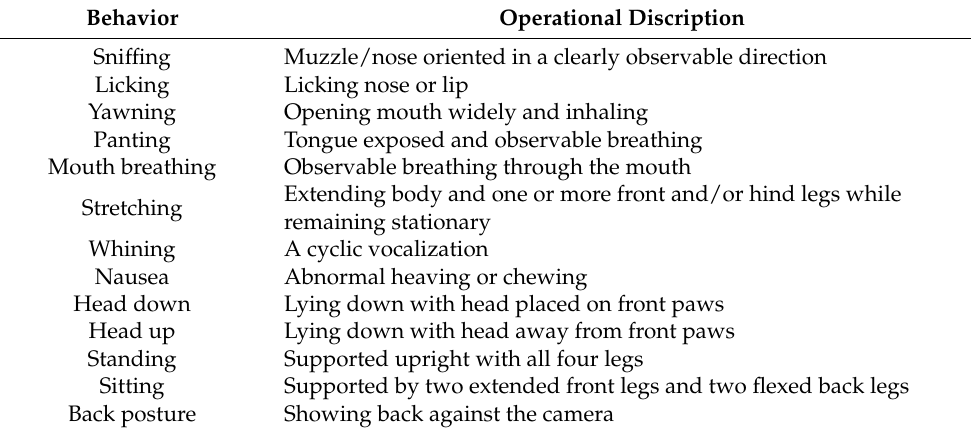
Showing back against the